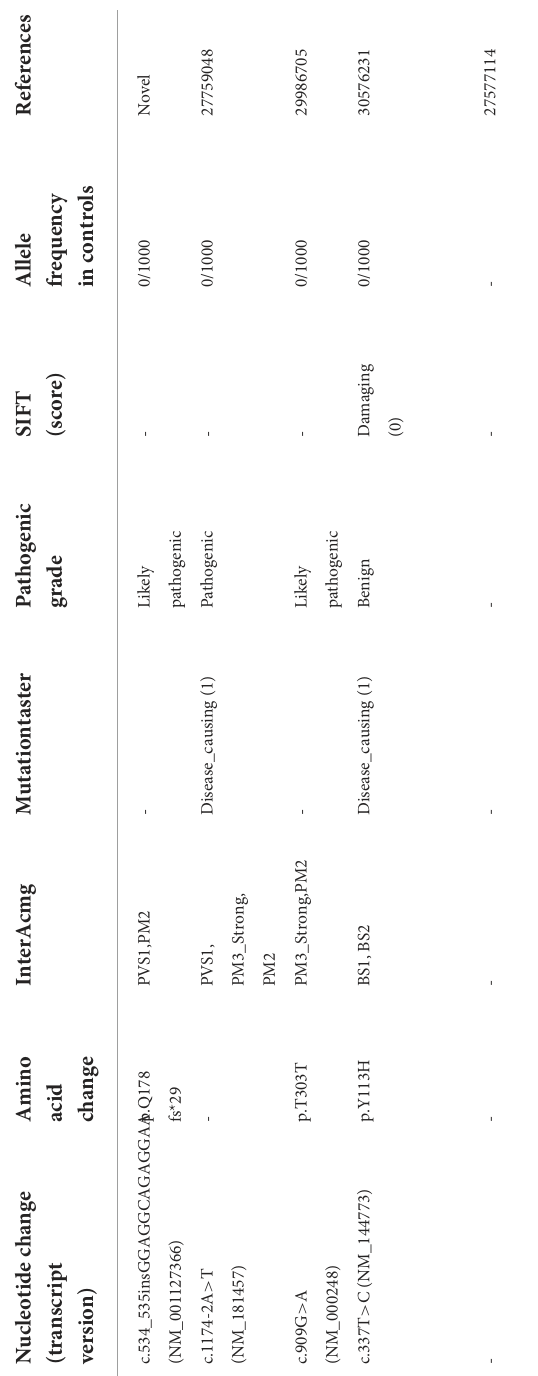
Table 1. In 8 recessive families, bi-allelic mutations were found in known deafness genes, part of which were identified by parental genotyping including p.H3204R and p.N2356K in USH2A (OMIM 608400), p.Q2137X and p.W778X in CDH23